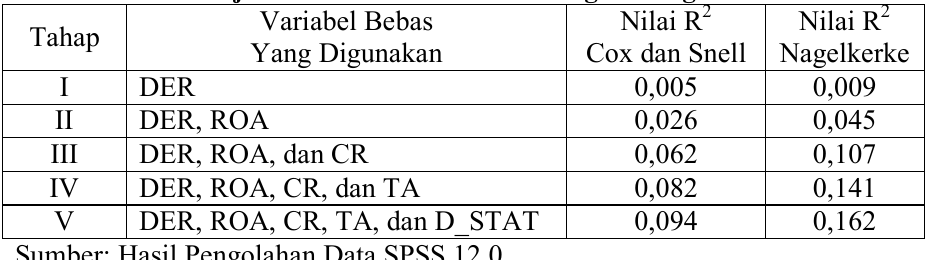
Tabel 10. (cid:12)ilai R 2 Cox dan Snell, (cid:12)ilai R 2 (cid:12)agelkerke